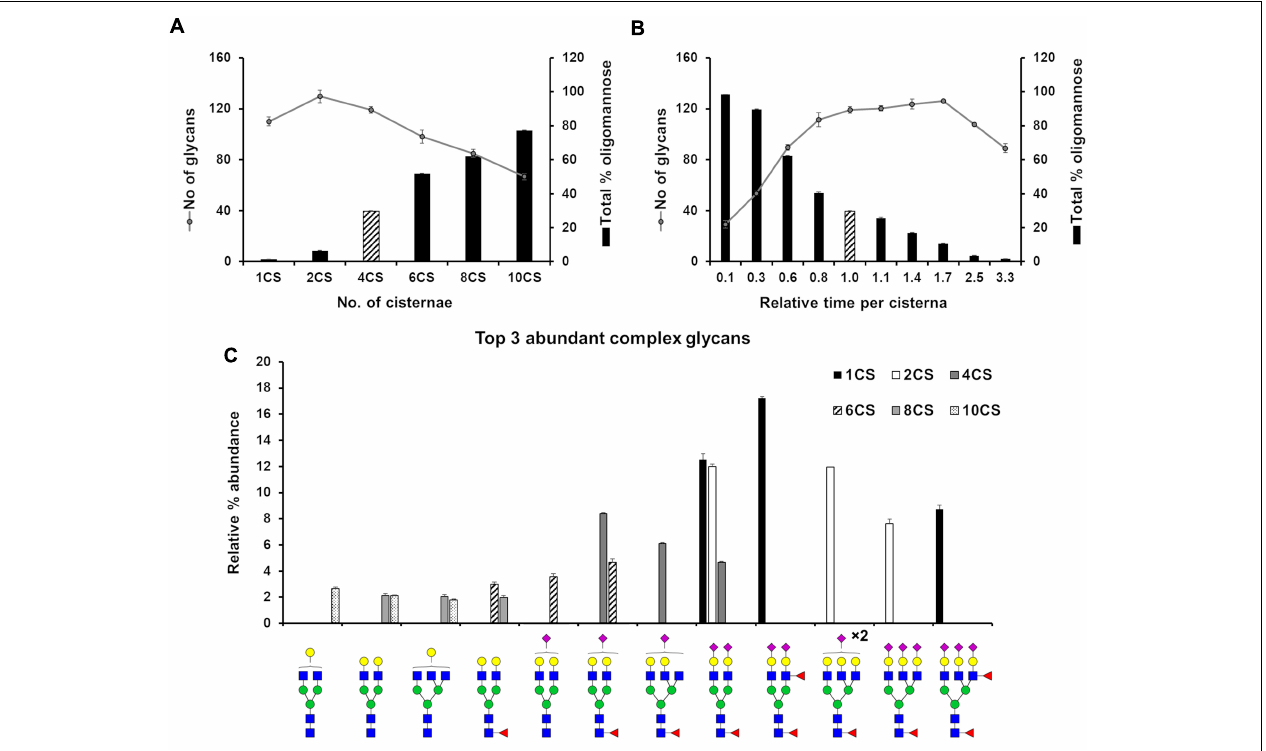
FIGURE 2 | Effect of cisternal number and transit time on glycan heterogeneity. (A) Total number of glycans (circles) and proportion of oligomannose glycans (bars) produced in silico when starting with parameters fitted for the WT HEK293T cell glycan profile altering the number of cisternal elements (CS) in the system from the four (striped bar) used in the WT HEK293T model. The distribution of enzymes across the model Golgi apparatus, the total effective rates for each enzyme and the total time spent in the Golgi apparatus was kept the same for each simulation. (B) As in “A” but varying the total time spent in the Golgi with four cisternae. Striped bar indicates transit time for the WT HEK293T cell model; the times shown for all other simulations are relative to this value. (C) Relative proportions of the three most abundant complex glycans predicted by the model Golgi apparatus when the number of cisternal elements are altered. For all simulations error bars show standard deviation for n =